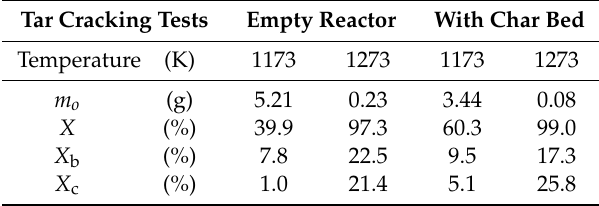
Table 5. Results of empty reactor tests and tests with char bed. Total amount of toluene collected m o , toluene removal e ffi ciency X , share of toluene converted into benzene and collected at the outlet X b , and share of toluene deposited as coke on the bed X c